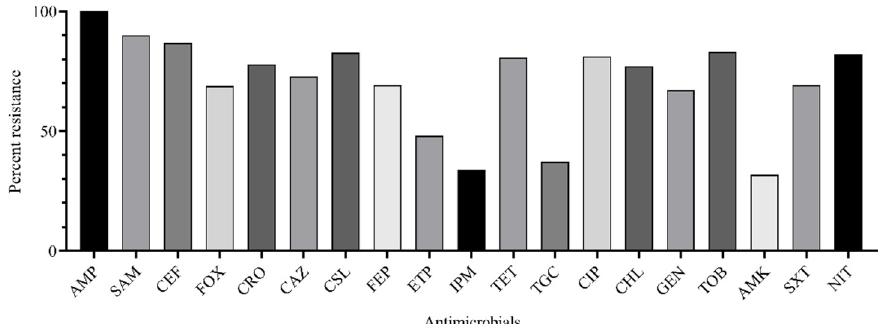
Figure 2. Rate of K. pneumoniae isolates ( n = 70) resistant to antimicrobials: AMP, ampicillin; SAM, ampicillin-sulbactam; CXM, cefuroxime; FOX, cefoxitin; CRO, ceftriaxone; CAZ, ceftazidime; CSL, cefepime; FEP, cefepime; ETP, ertapenem; IPM, imipenem; TET, tetracycline; TGC, tigecycline; CIP, ciprofloxacin; CHL, chloramphenicol; GEN, gentamicin; TOB, tobramycin; AMK, amikacin; SXT, trimethoprim-sulfamethoxazole; NIT, nitrofurantoin.